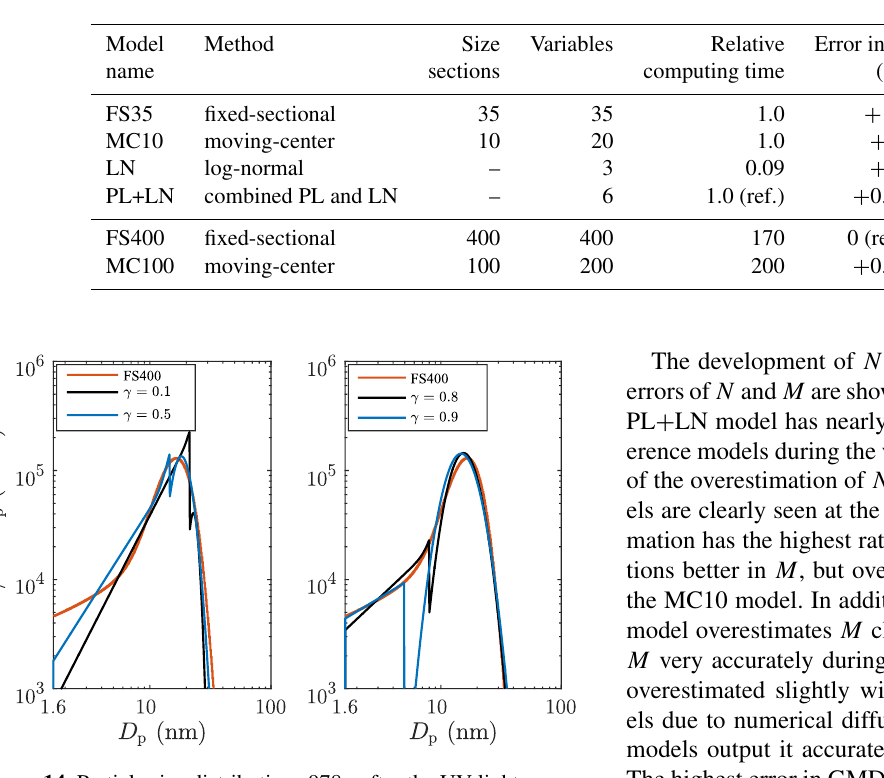
Table 3. Computational costs of different models and relative errors of number ( N ) and mass ( M ) concentrations obtained from the time of 1663s after the UV lights were switched on in the chamber simulation. The number of variables compared to size sections in MC models is 2-fold because the centers of the size sections need to be stored in addition to the concentrations of the sections. Relative values are calculated using a model with (ref.) as the reference model.